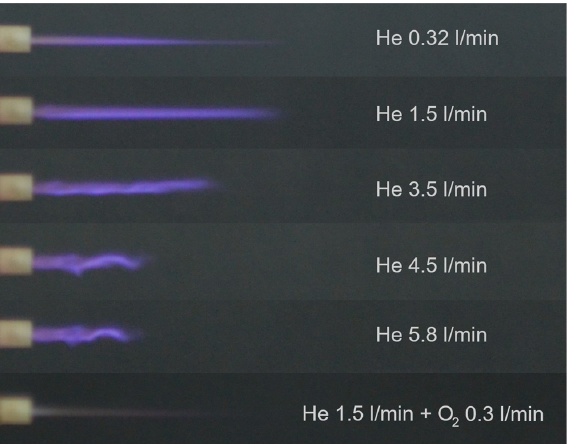
Figure 4. The shape of the discharge for different gas flow rates and composition of the mixture.